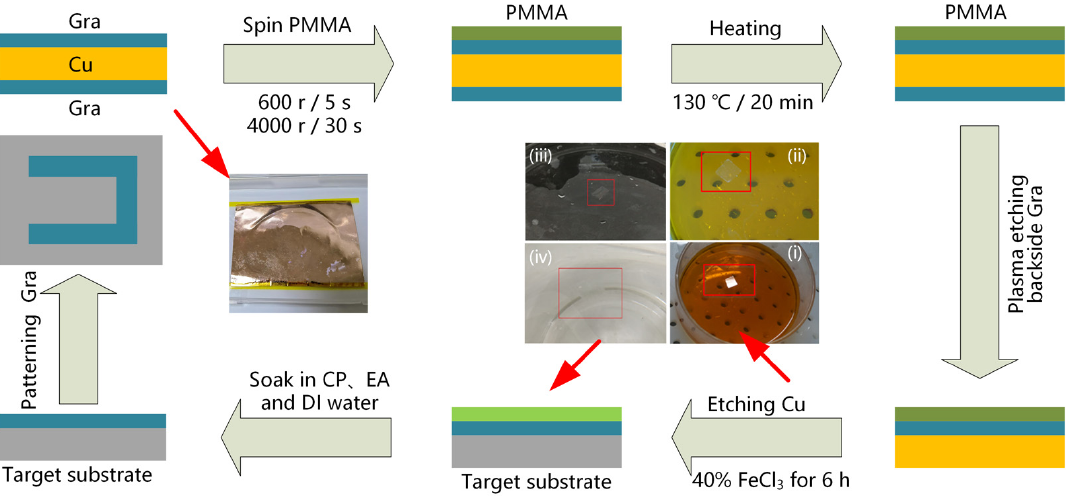
Figure 2. Schematic of transferring graphene layer to target substrate (including patterning graphene).